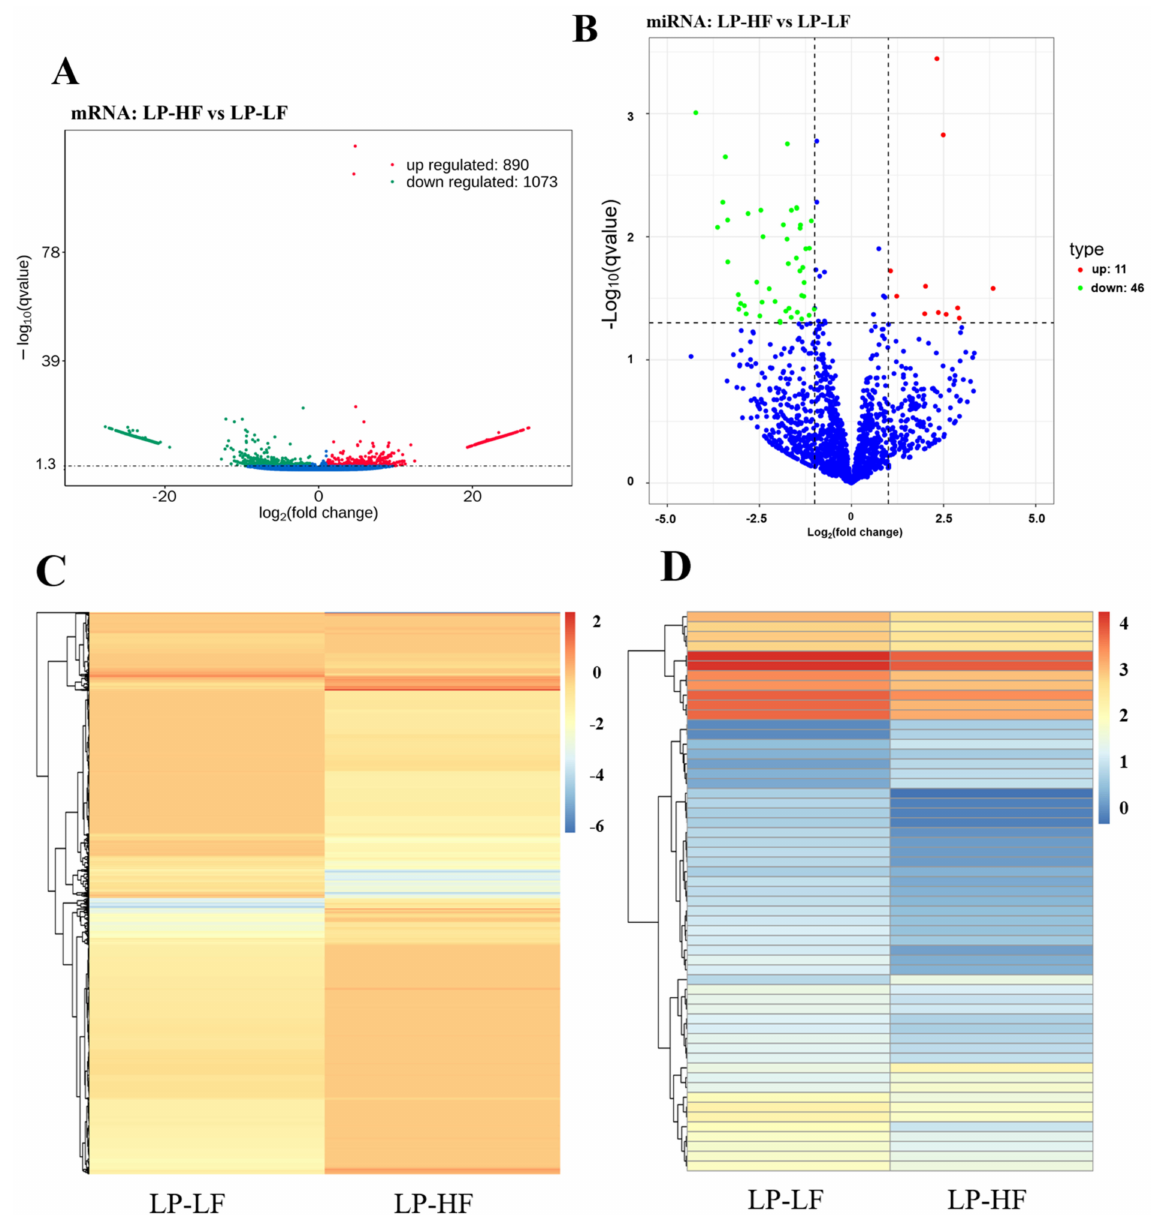
Figure 4. DEGs and DEMs analysis. Volcano plot of the identified genes ( A ) and the miRNAs ( B ) in the LP-HF vs LP-LF, where red and green represent the up- or down-regulation, respectively. Heat maps showing the expression patterns of 1963 DEGs ( C ) and 57 DEMs ( D ) in the LP-HF vs